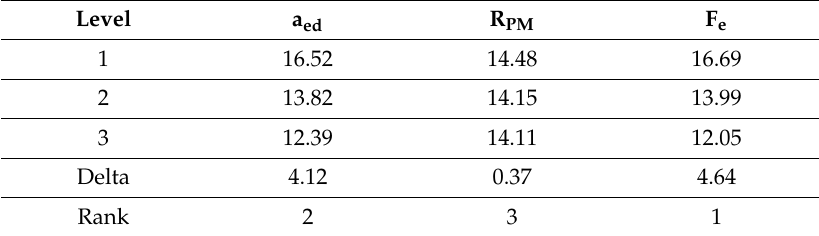
Table 6. The impact level of cutting parameters on part’s medium grinding time ( t